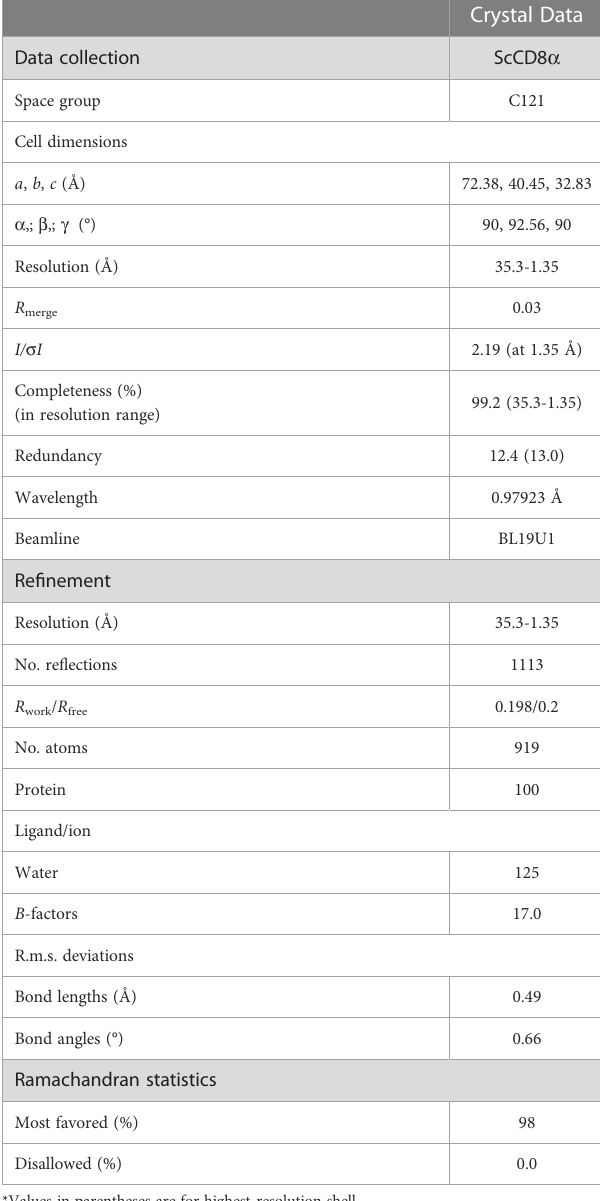
TABLE 2 Data collection and re fi nement statistics (molecular